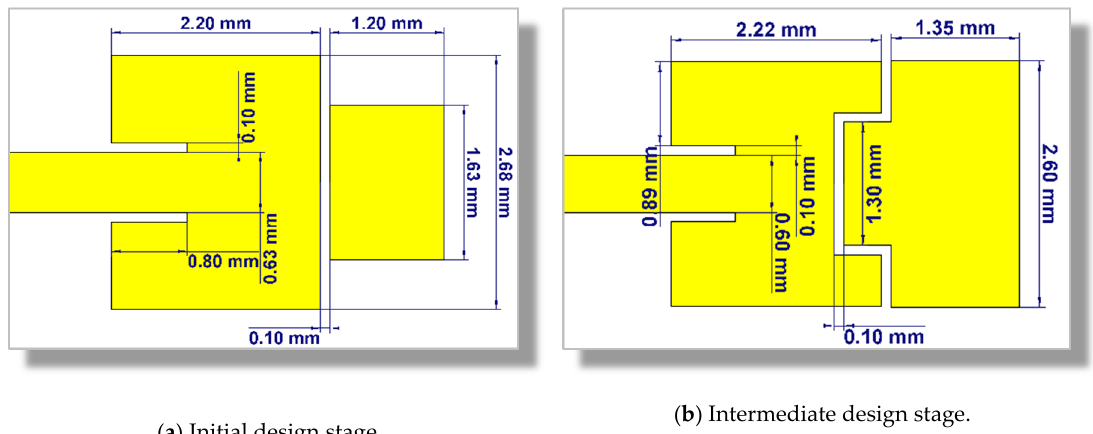
Figure 6. Dimensions of the dual-patch for the initial and intermediate design stages.